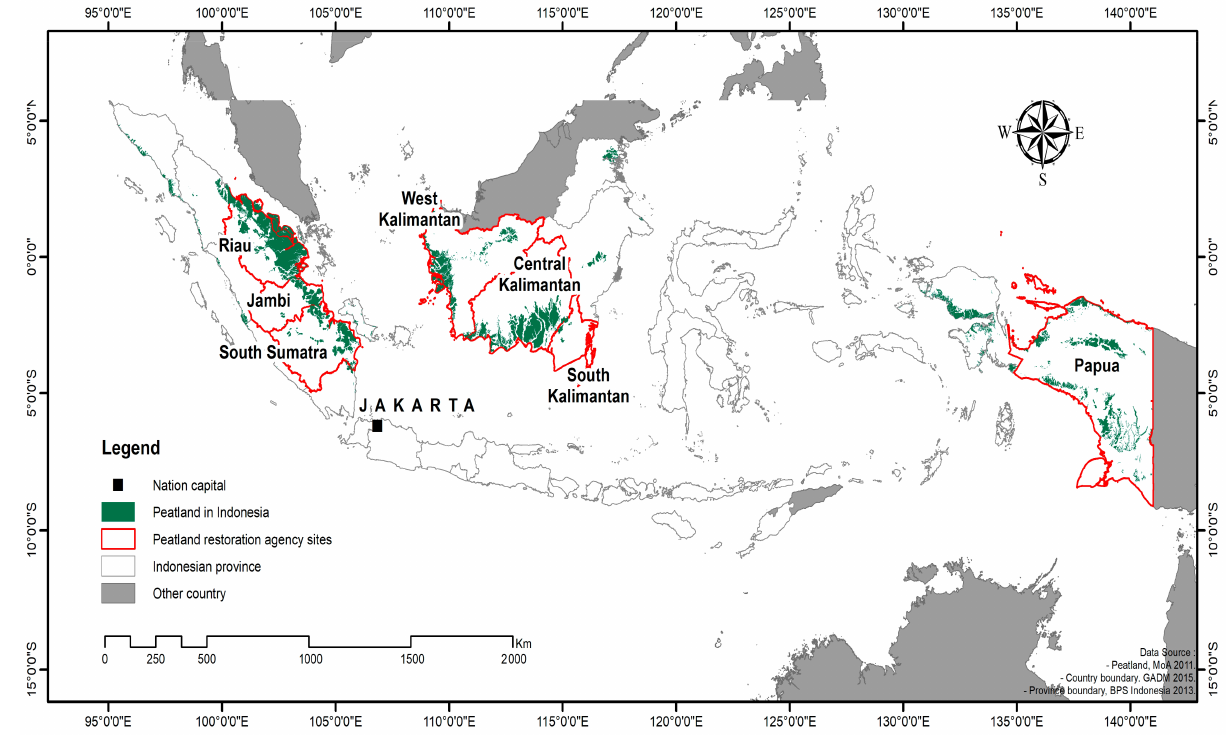
Figure 1. Distribution of peatlands and peatland restoration areas in Indonesia, adapted from Ref.